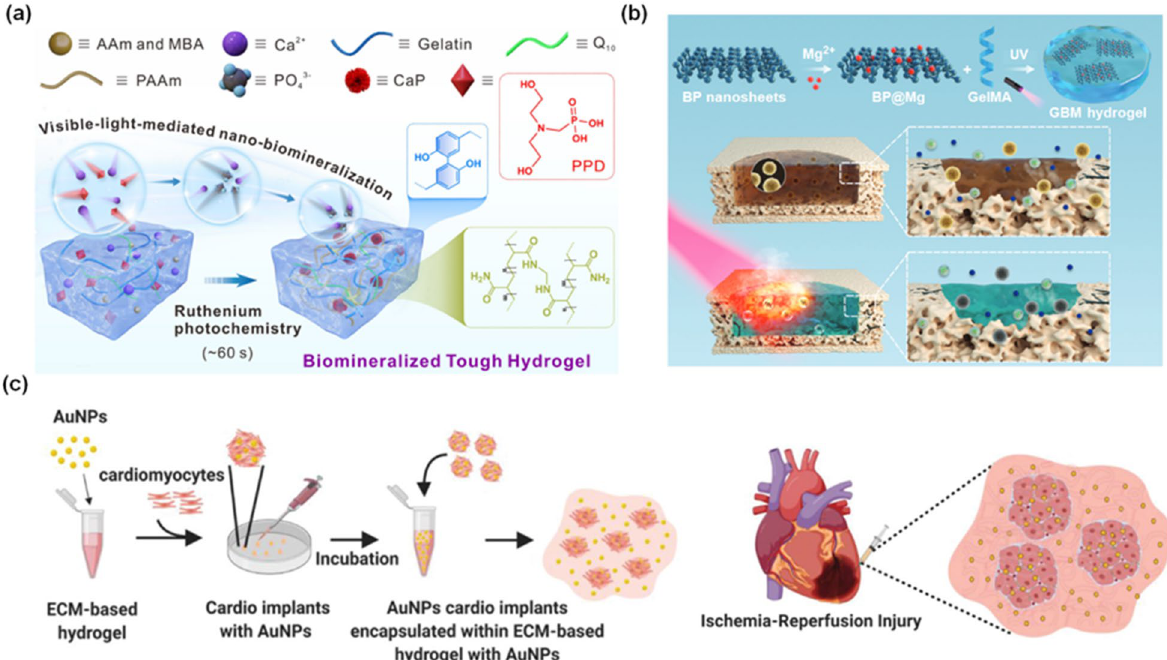
Fig. 5 a Schematic diagram of a visible‑light‑mediated nano‑biomineralization method for the synthesis of BTH through the photocatalytic activity of ruthenium. Reproduced with permission from [88], copyright American Chemical Society, 2022. b Schematic images of the fabrication process of GelMA‑BP@Mg composed of GelMA and BP@Mg and exhibiting the photothermal properties of the GelMA‑BP@Mg. Reproduced with